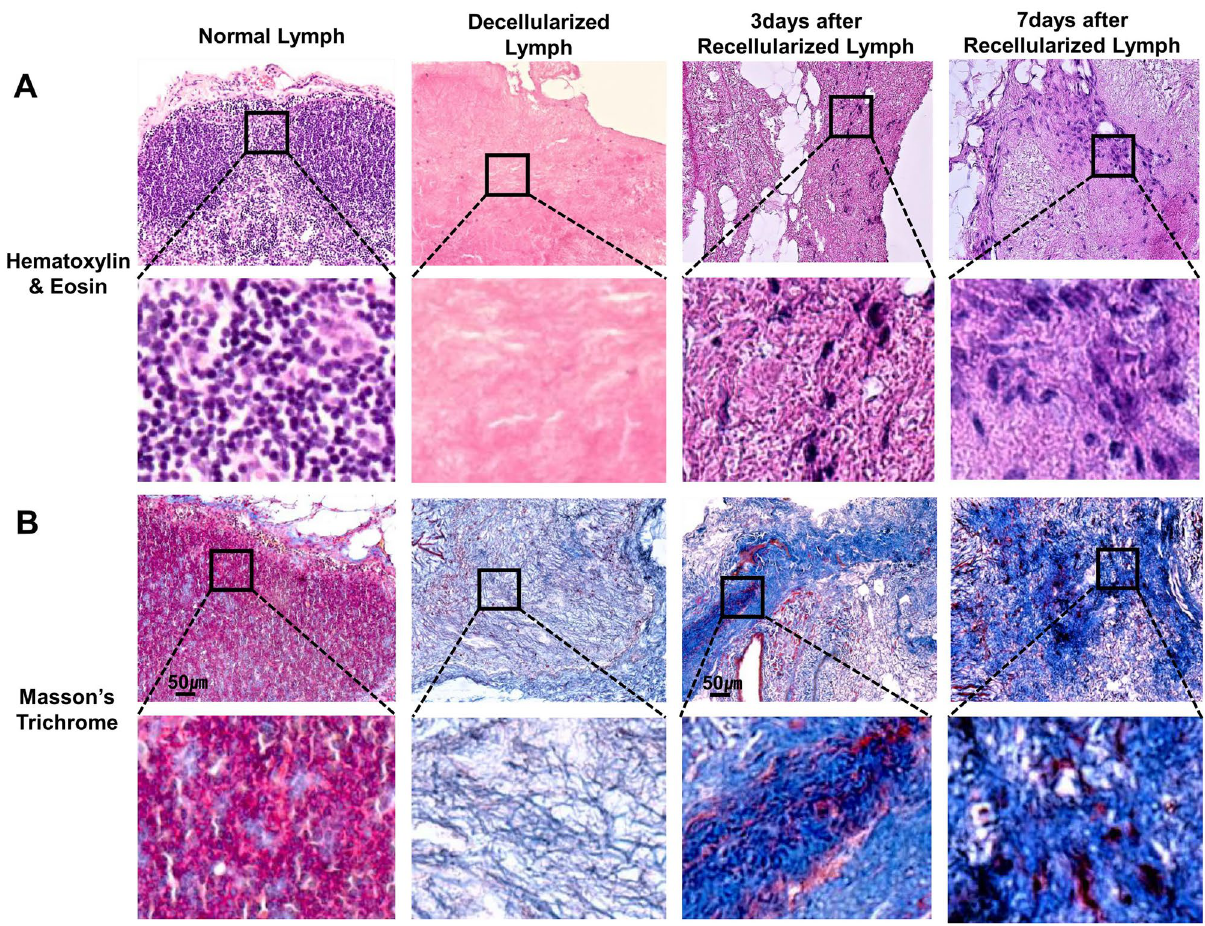
Figure 1. Histopathological assessment of lymph node decellularization and recellularization. ( A ) Hematoxylin &eosin staining of lymph node scaffolds; native lymph node, decellularization treated with 0.075% sodium dodecyl sulfate, recellularization with ADSCs (1 × 10 6 /50 µL). ( B ) Masson’s trichrome staining showing muscle (red) and collagen (blue)